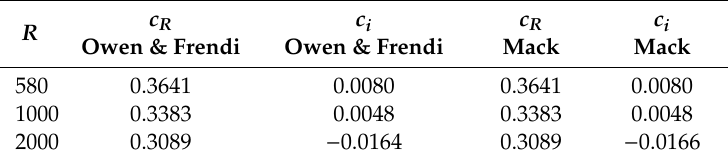
Table 2. Eigenvalues for Blasius flow at different Reynolds numbers and 𝛼 = 0.179.